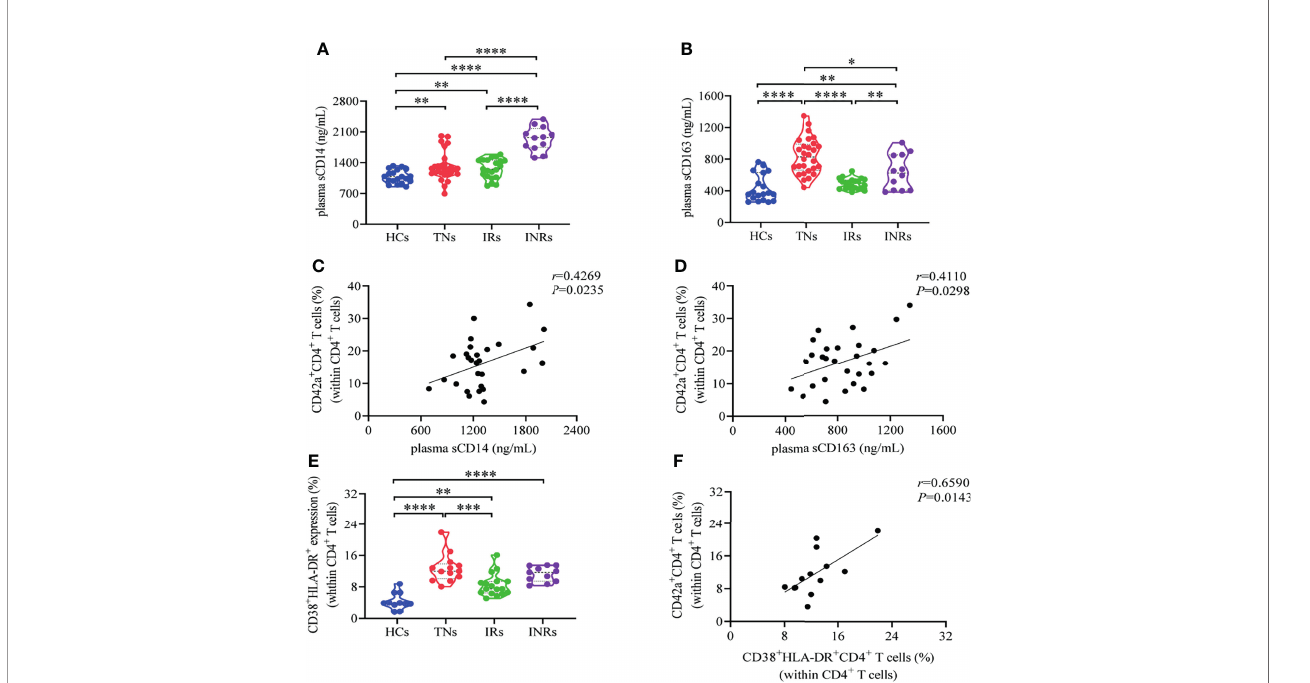
FIGURE 4 | An increased frequency of platelet-CD4 + T cell aggregates is positively correlated with sCD14 and sCD163 during HIV-1 infection. (A) Serum level of sCD14 from HCs (n=19), TNs (n=28), IRs (n=21) and INRs (n=12). (B) Serum level of sCD163 from HCs (n=19), TNs (n=28), IRs (n=21) and INRs (n=12). (E) Frequencies of CD38 + HLA-DR + CD4 + T cell in CD4 + T cells from HCs (n=11), TNs (n=13), IRs (n=17) and INRs (n=11). Correlation between (C) plasma sCD14 levels (n=28), (D) plasma sCD163 levels (n=28), and (F) CD38 + HLA-DR + CD4 + T cells (n=13) and the frequencies of platelet-CD4 + T cell aggregates in CD4